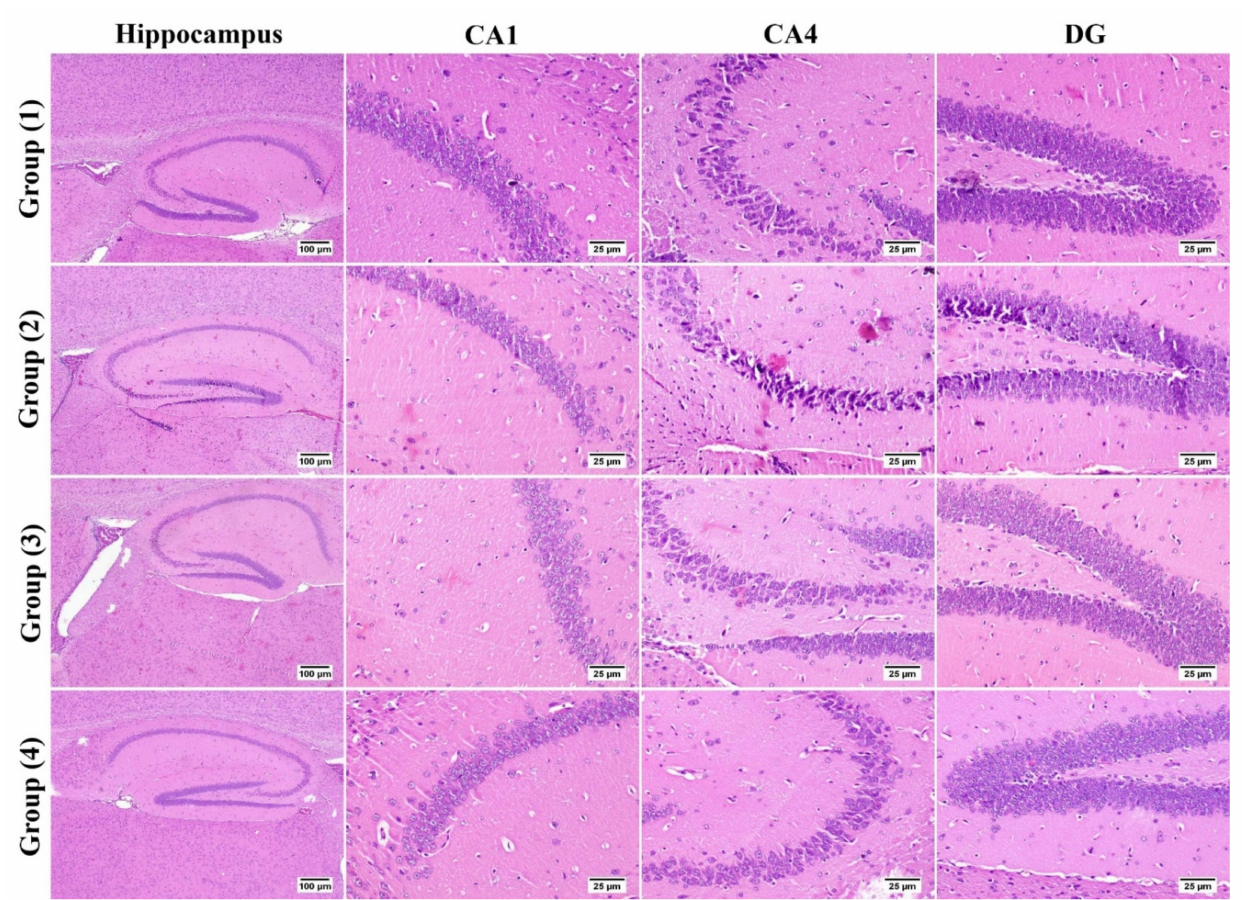
Figure 6. Photomicrograph of brain, hippocampus region (H&E stain). Normal hippocampus in group (1), group (2) showed marked degenerated neurons in CA4 and DG regions. Group (3) showed few degenerated neurons. Group (4) showed apparently normal hippocampus.